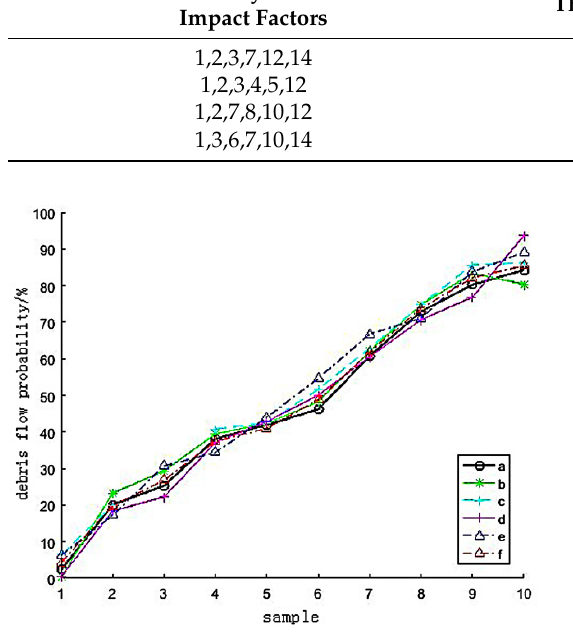
Table 10. Correspondence between the influence factor and the curve in Figure 7. Artificially Selected The Corresponding Curve in Figure 7 Impact Factors